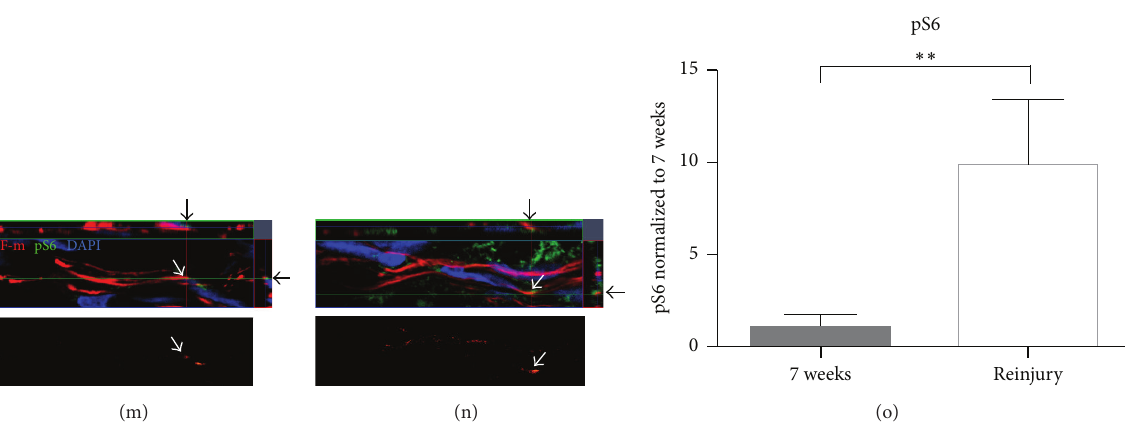
Figure 3: Stalled axons upregulate PSM upon reinjury. Representative confocal images from ascending CNS axons immunolabeled for NF-m (red) in PNGs at 7 weeks after grafting ((a), (d), (g), (h), and (m), the same as Figure 2) and the reinjury group (b, e, h, k, and n). The image sets colabeled for 4EBP1 (a, b), p4EBP1 (d, e), eIF2 𝛼 (g, h), peIF2 𝛼 (j, k), and pS6 (m, n) are shown. Similar to Figure 2, top panel of each image set represents exposure matched orthogonal projections showing XY , XZ, and YZ planes indicating axon-specific signal (arrows). Bottom panel of each image set shows the subtracted image with axon-only signal for specific protein as indicated by an intensity spectrum. Scale bar = 5 𝜇 m. Graphs (c), (f), (i), (l), and (o) show quantification of relative immunolabeling intensity for the subtracted axon-only signals for 4EBP1, p4EBP1, eIF2 𝛼 , peIF2 𝛼 , and pS6, respectively. Data are expressed as fold change in signal intensity compared with 7-week grafts ± SD. ∗ 𝑝 ≤ 0.05 and ∗∗ 𝑝 ≤ 0.01 , using Holm-ˇS´ıd´ak post hoc